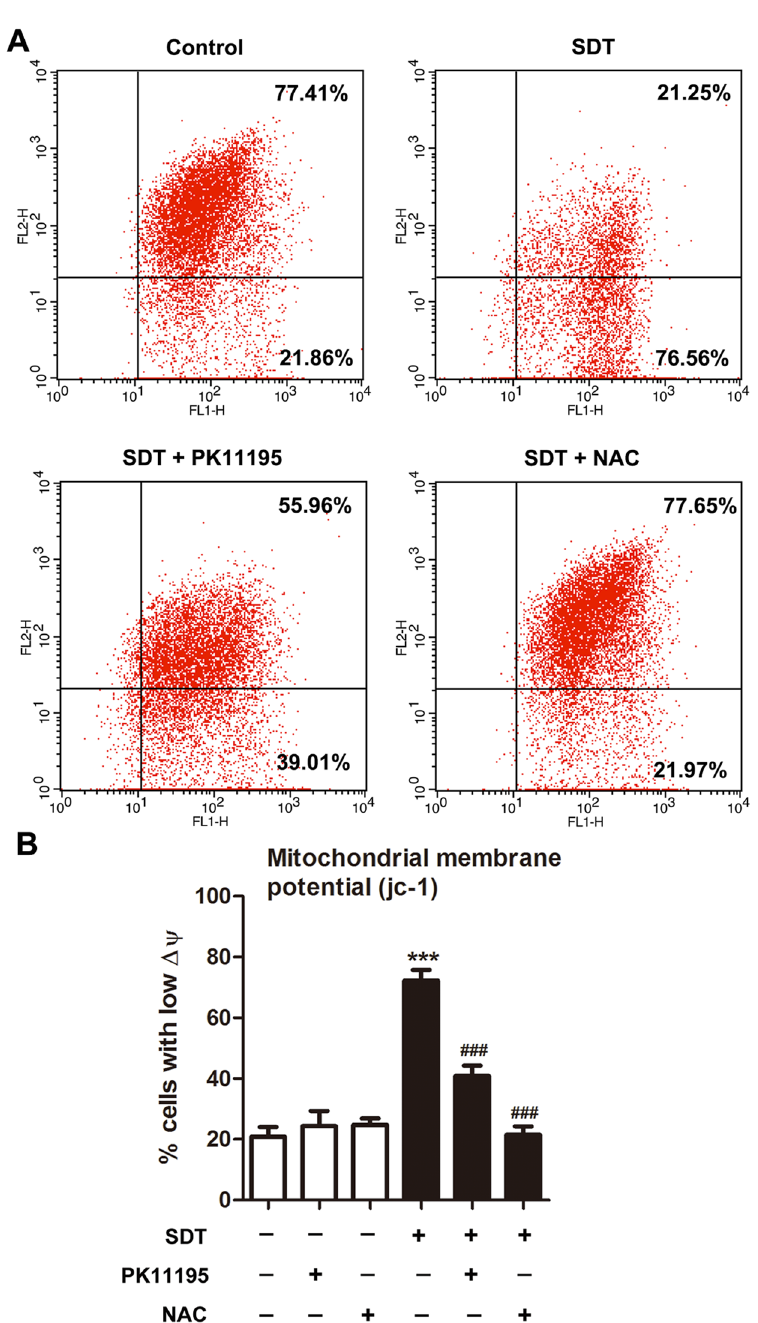
Fig 4. Effects of PK 11195 and NAC on SDT-induced Δ C m loss, as determined with JC-1 by flow cytometer. THP- 1 macrophages were treated for 1 hours with 5-aminolevulinic acid mediated sonodynamic therapy (ALA-SDT), with or without pretreatment of PK 11195 or NAC. (A) Cells with polarized mitochondria are found in the upper right quadrant, corresponding to high emission of fluorescence at both 590 nm (FL2-H, orange-red) and 527 nm (FL1-H, green), whereas cells with depolarized mitochondria are present in the lower right quadrant. (B) Quantifications of percentage of cells with low mitochondrial membrane potential ( Δ C m ) in the indicated groups. (cid:3)(cid:3)(cid:3) P < 0.001 compared to no treatment group, ### P < 0.001 compared to ALA-SDT treated